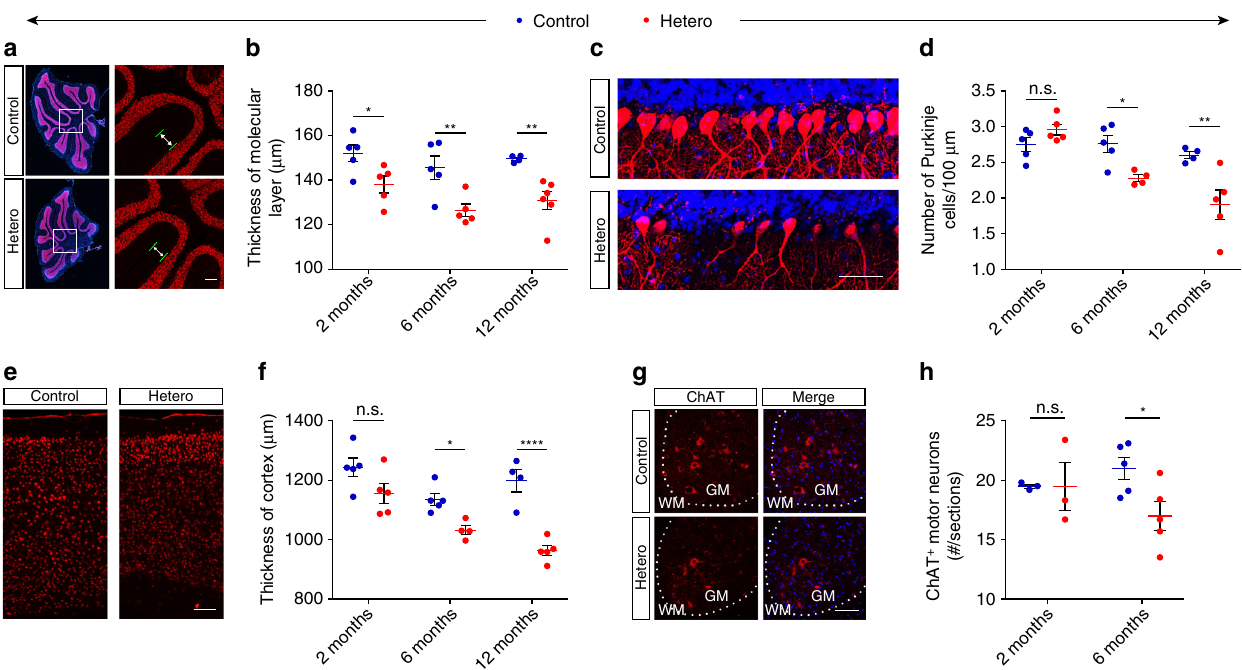
Fig. 5 Expression of GFP-PR 28 causes motor-related neurodegeneration. a Representative images showing the size of the cerebellum and the thickness of the molecular layer of control and GFP-PR 28 heterozygous mice at 6 months of age. Neu-N (red), Hoechst (blue). White squares indicates enlarged area. Green lines indicate the thickness of the molecular layer. Scale bar represents 100 μ m. b Quanti fi cation of the thickness of molecular layer of control and GFP-PR 28 heterozygous mice at 2, 6, and 12 months of age. Two months, n = 5, 5 mice; 6 months, n = 5, 5 mice; 12 months, n = 4, 6 mice. c Representative images showing the numbers of cerebellar Purkinje cells of 6-month-old control and GFP-PR 28 heterozygous mice. Calbindin (red), Hoechst (blue). Scale bar represents 50 μ m. d Quanti fi cation of the numbers of calbindin positive Purkinje cells of control and GFP-PR 28 heterozygous mice at 2, 6 and 12 months of age. Two months, n = 5, 5 mice; 6 months, n = 5, 5 mice; 12 months, n = 4, 5 mice. e Representative images showing the thickness of motor cortex of control and GFP-PR 28 heterozygous mice at 6 months of age. Scale bar represents 100 μ m. f Quanti fi cation of the thickness of the motor cortex of control and GFP-PR 28 heterozygous mice at 2, 6, and 12 months of age. Two months, n = 5, 5 mice; 6 months, n = 5, 4 mice; 12 months, n = 4, 5 mice. g Representative images showing the numbers of ChAT-positive motor neurons in the lumbar spinal cord of 6-month-old control and GFP-PR 28 heterozygous mice. GM (gray matter), WM (white matter). Scale bar represents 100 μ m. h Quanti fi cation of the numbers of ChAT-positive motor neurons of control and GFP-PR 28 heterozygous mice at 2 and 6 months of age. Two months, n = 3, 3 mice; 6 months, n = 5, 5 mice. All data aredisplayed as mean